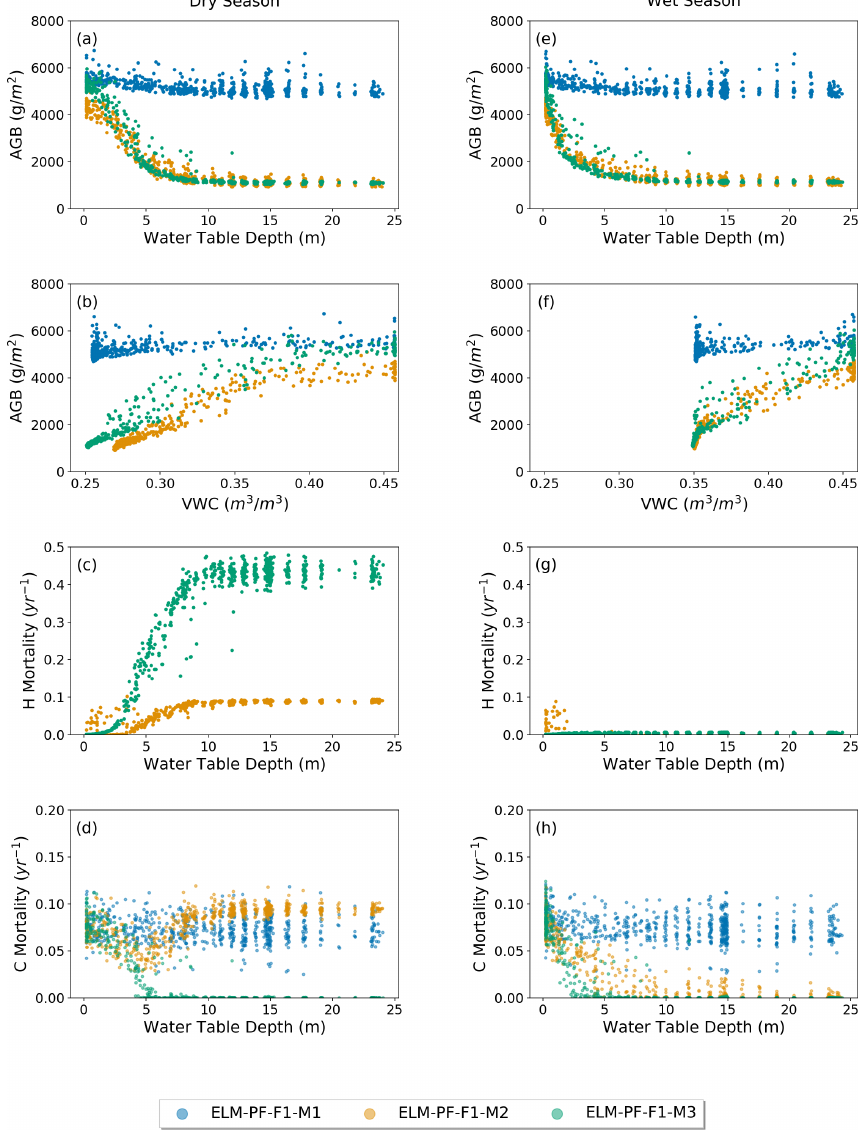
Figure 6. The blue, orange, and green circles represent results from ELM-PF-F1-M1, ELM-PF-F1-M2, and ELM-PF-F1-M3, respectively. Simulated AGB with respect to groundwater table depth, WTD (a, e) , top 1m soil water content, VWC (b, f) , simulated hydraulic mortality (c, g) , and carbon starvation mortality (d, h) with respect to WTD in the dry season (a–d) and wet season (e–h) .